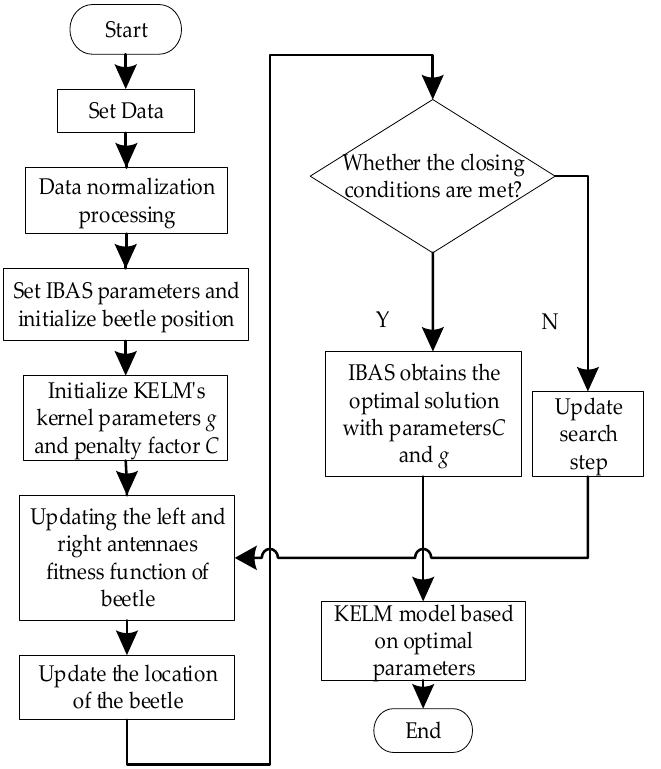
Figure 1. IBAS optimization KELM parameter flow